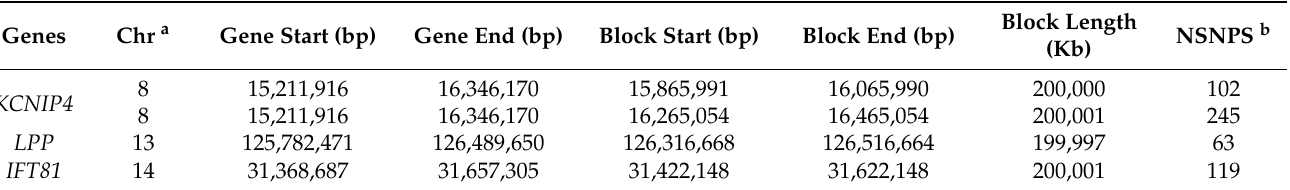
Table 1. List of the genes selected by the Venn diagram that intersects with haplotype blocks on Licha black pig.